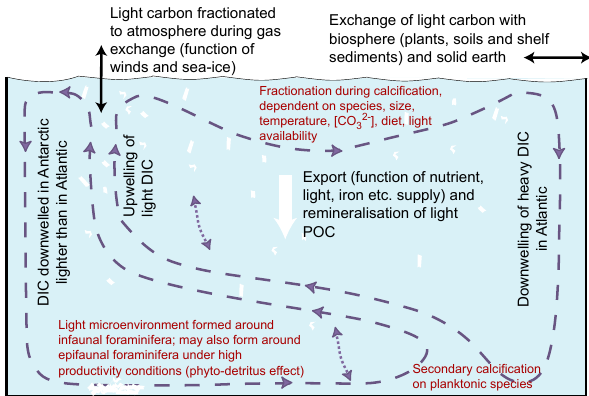
Fig. 1. Schematic of processes influencing δ 13 C recorded in cal- cium carbonate from foraminiferal shells. Processes in large font affect δ 13 C of dissolved inorganic carbon (DIC) in open seawa- ter; processes in small font affect the difference between recorded δ 13 C and seawater δ 13 C. POC ≡ particulate organic carbon. Heavy (light) DIC refers to DIC rich (poor) in 13